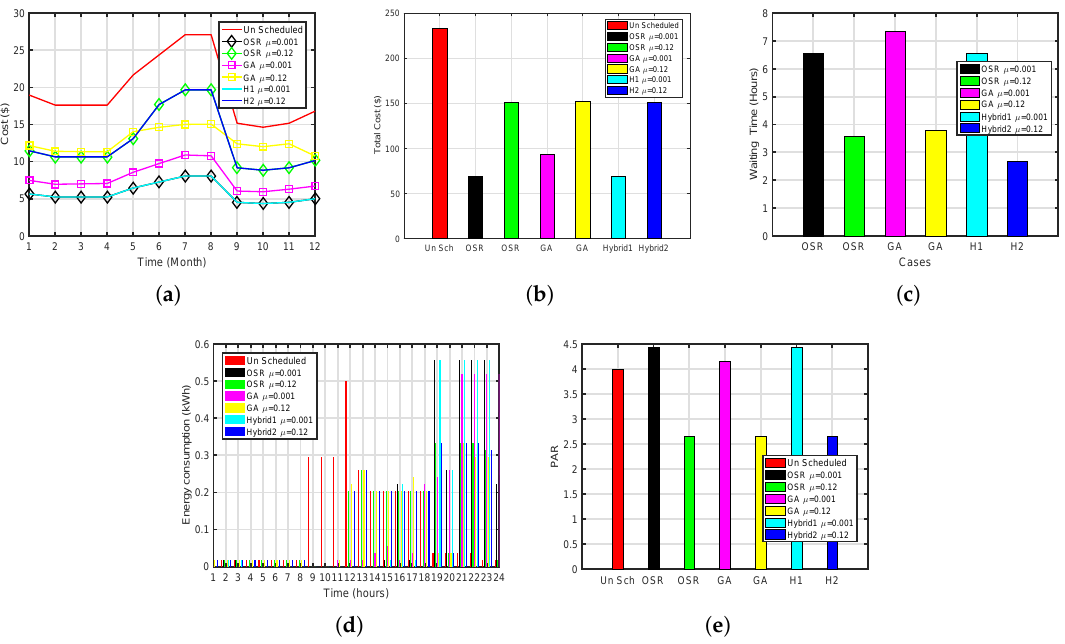
Figure 4. Hybrid Plots for Cloth Dryer (OSR-GA). ( a ) Monthly Cost of Cloth Dryer (OSR-GA), ( b ) Total Cost of Cloth Dryer (OSR-GA), ( c ) Waiting Time of Cloth Dryer (OSR-GA), ( d ) Energy Consumption of Cloth Dryer (OSR-GA), ( e ) PAR of Cloth Dryer (OSR-GA).